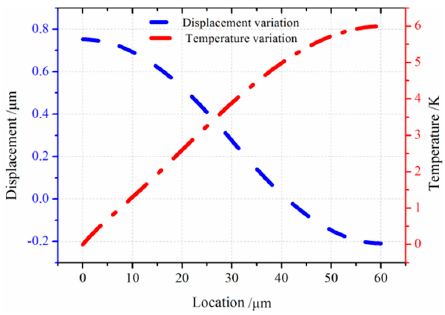
Figure 8. The path analysis result of temperature distribution and displacement variation.